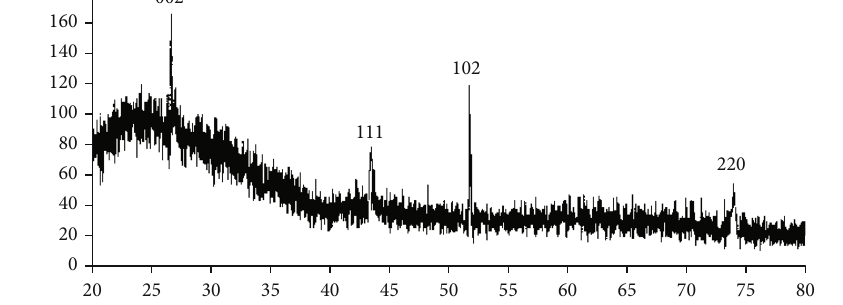
Figure 4: XRD graph of DLC coating on Al.